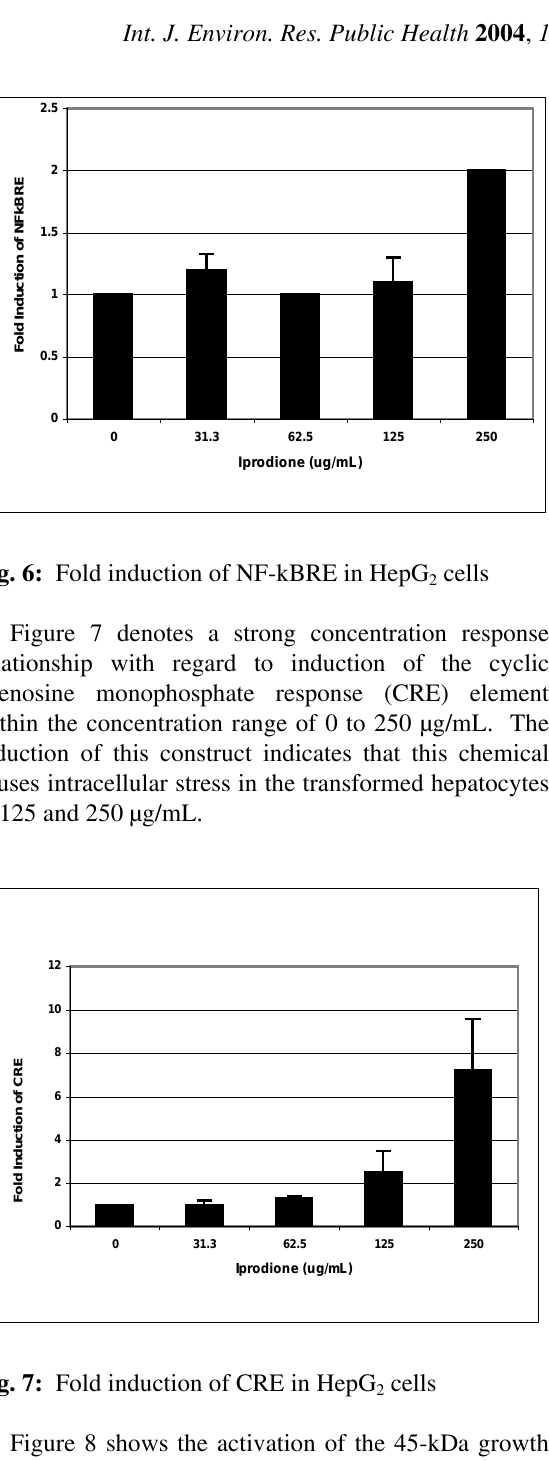
Fig. 7: Fold induction of CRE in HepG cells 2 Figure 8 shows the activation of the 45-kDa growth arrest and DNA damage (GADD45) in HepG cells 2 exposed to iprodione. Data presented in this figure indicate a gradual increase in fold induction of this construct as the concentration of iprodione increases. Fig. 5: Fold induction of HSP70 in HepG cells 2 The mean levels of fold inductions were 1.0 ± 0, 1.0 ± 0, 1.0 ± 0, 1.3 ± 0.5, and 2.7 ± 0.5, in 0, 31.3, 62.5, 125, Figure 6 denotes the induction of the nuclear factor and 250 µg/mL, respectively. A similar trend was k-binding site response element (NF-kBRE) at a observed with regard to the induction of the 153-kDa concentration of 250 µg/mL, indicating that iprodione growth arrest and DNA damage (GADD153) gene causes oxidative damage to HepG cells. This may be 2 promoter (Figure 9). These results indicate the due to the activation of primary stress factors or genotoxic potential of secondary stimuli such as inflammatory cytokines.